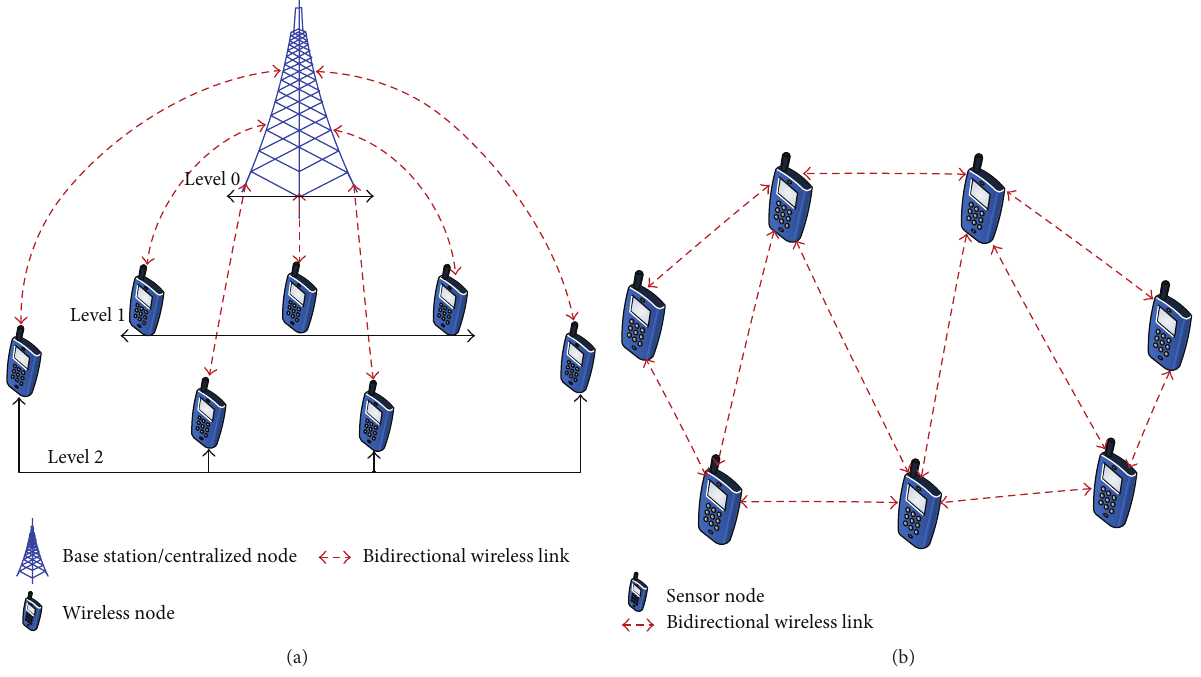
Figure 4: Information and resource sharing in the organization of networks for cross-layer. (a) Centralized method and (b) distributed method. (a) Centralized method is used to share information between sensor nodes in the network while (b) each sensor node used single/more than one path to transmit data to the destination.